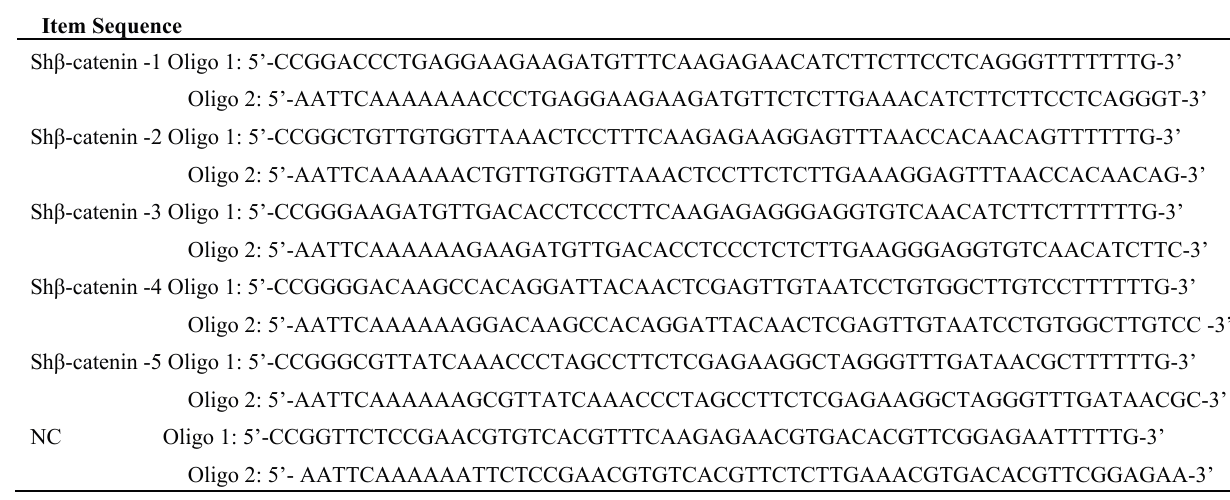
Table 1. The sequence of synthesized